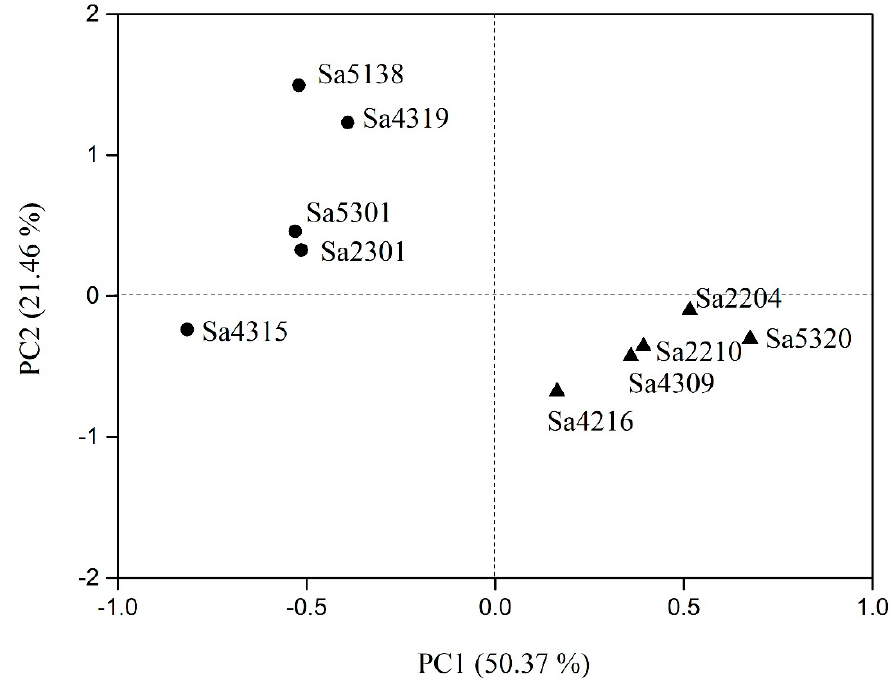
Figure 4. Plot of PC1 versus PC2 from principal component analysis of desiccation-related traits. Circles denote nonresistant genotypes (i.e., Sa2301, Sa4315, Sa4319, Sa5138 and Sa5301); triangles denote resistant genotypes (i.e., Sa2204, Sa2210, Sa4216, Sa4309 and Sa5320).